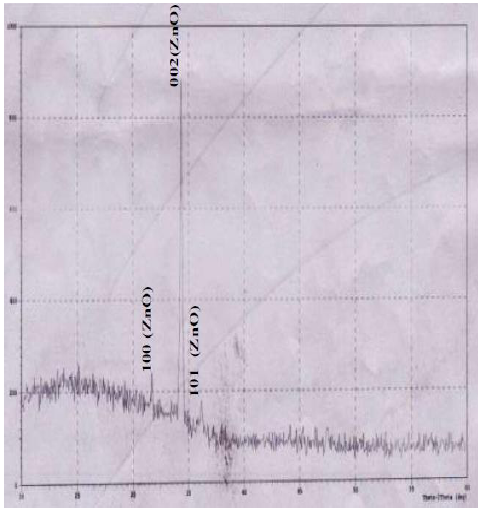
Fig. 2: XRD spectra of Z